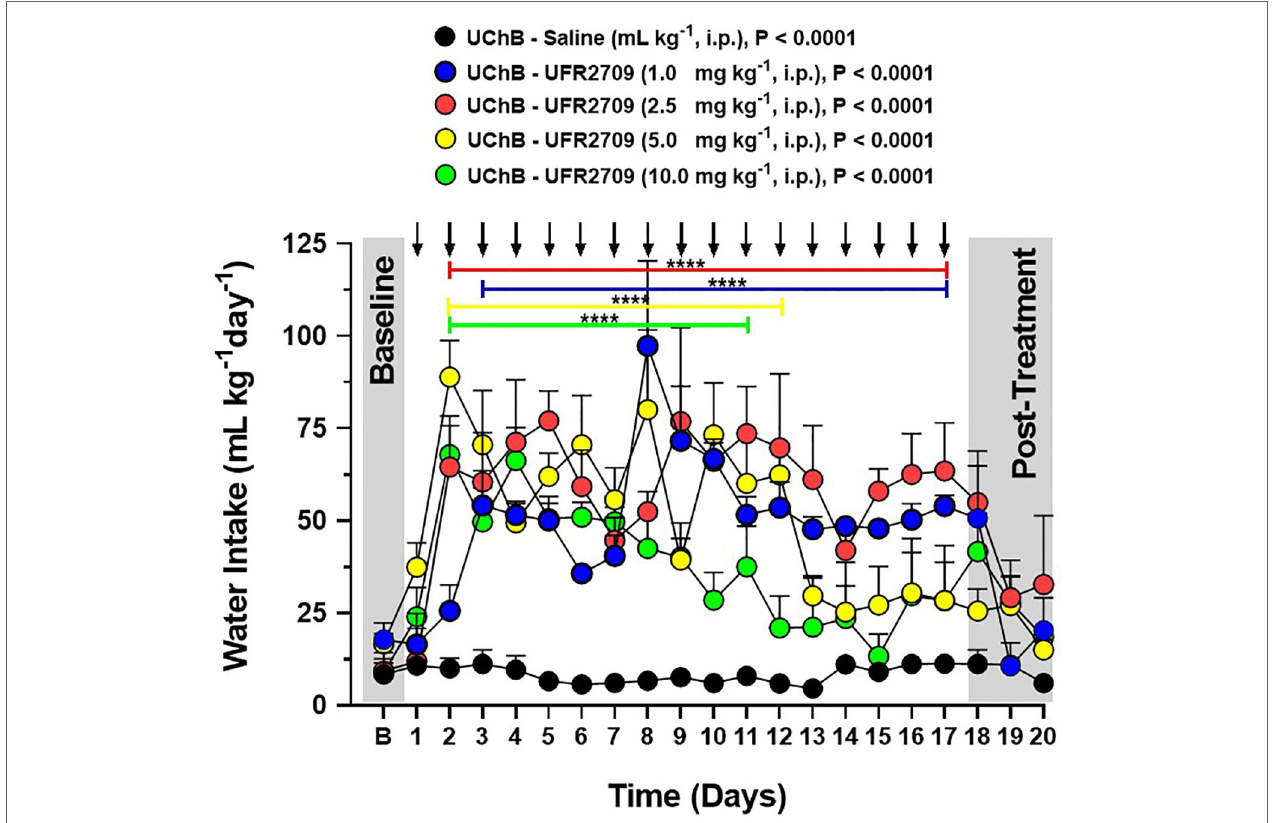
FIgURE 2 | Influence of 17 days of UFR2709 treatment on the water intake of high-alcohol-drinking UChB rats under a 24-h access two-bottle free choice paradigm. The baseline water consumption of each experimental group is the average water intake during the last three days before the treatment period. For 17 consecutive days, rats (n = 5 per group) were administered a single i.p. injection of UFR2709 (1, 2.5, 5, or 10 mg/kg/day) or saline (1 mL/kg/day) at 15:00 h, and water intake was recorded at 14:00 h the next day. Water intake data are expressed as mean ± SEM (mL/kg/day) . Two-way ANOVA with Tukey’s multiple comparison test was used to analyze the effect of UFR2709 treatment on water intake (P < 0.0001). Arrows indicate the time points of UFR2709 (1, 2.5, 5, or 10 mg/kg) or saline (1 mL/kg) administration via i.p. injection.